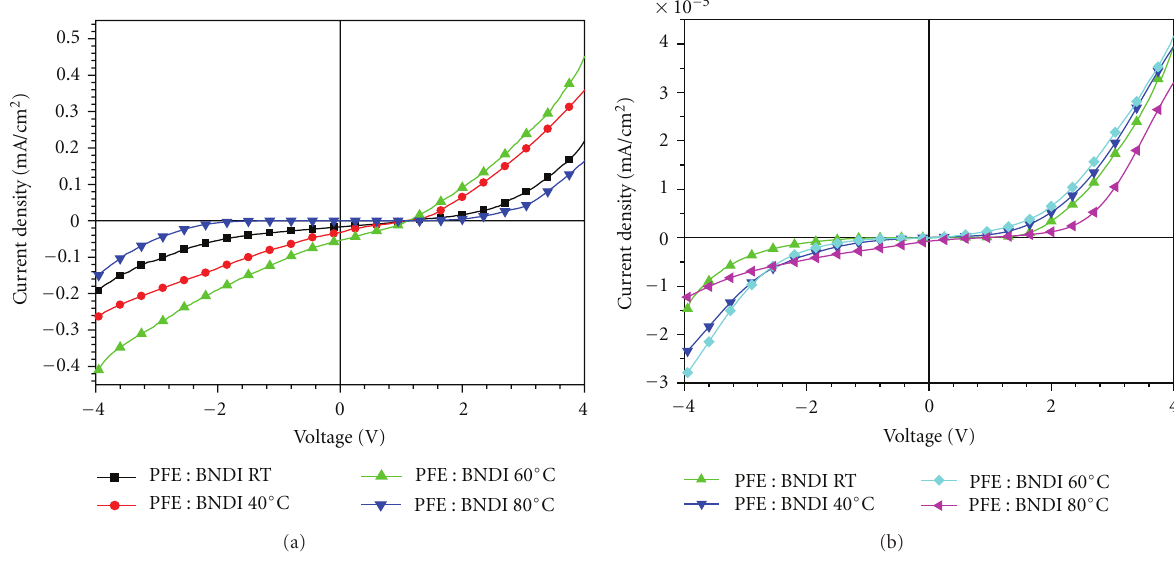
Figure 6: Current density-voltage curves of ITO/PEDOT:PSS/PFE:BNDI (3:1) at RT and di ff erent annealing temperatures/Al (a) under 1mW/cm 2 at 368 nm UV light and (b) in